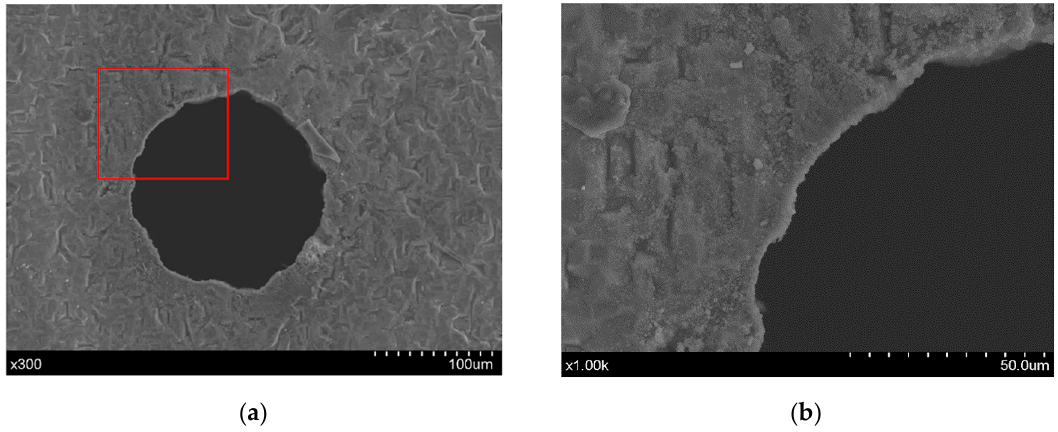
Figure 11. Exit details of direct micro-trepanning results, where ( a ) is an overall view, while ( b ) shows the details within the red square. The combination of parameters is the same as that in Figure 10.